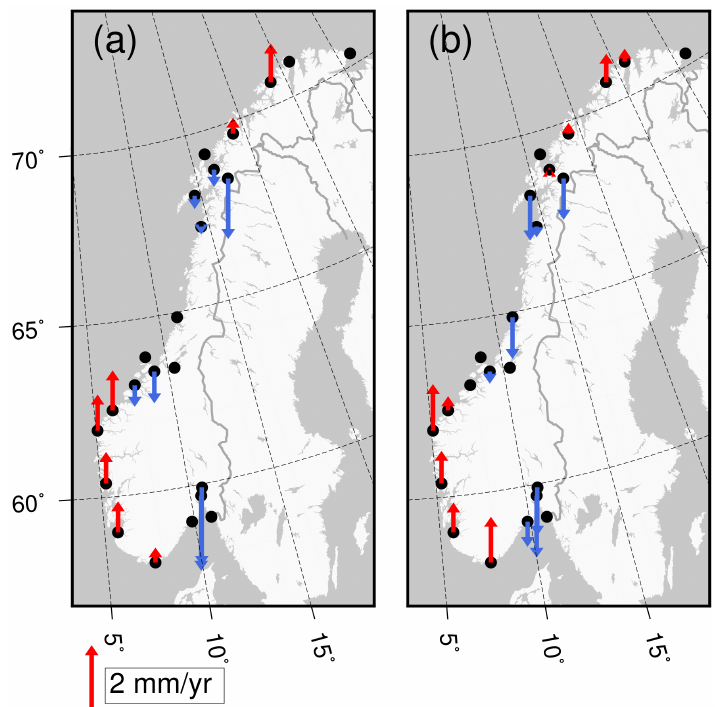
Figure 3. Relative sea-level rates at the Norwegian tide gauges for the periods 1960–2010 ( a ) and 1984–2014 ( b ). The standard error of the rates varies from 0.2 to 0.5 mm/year for the period 1960–2010 and from 0.5 to 1.0 mm/year for the period